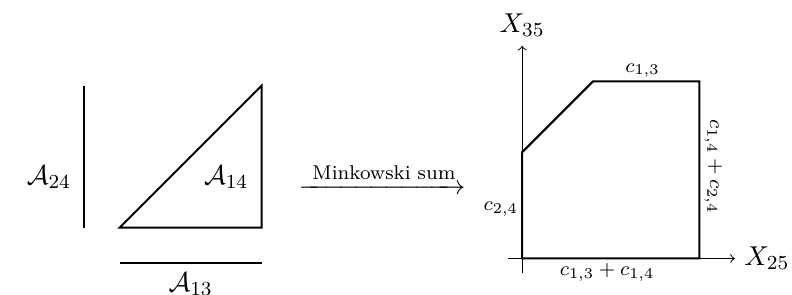
Figure 4 . The ABHY associahedron A 2 (pentagon) as a Minkowski